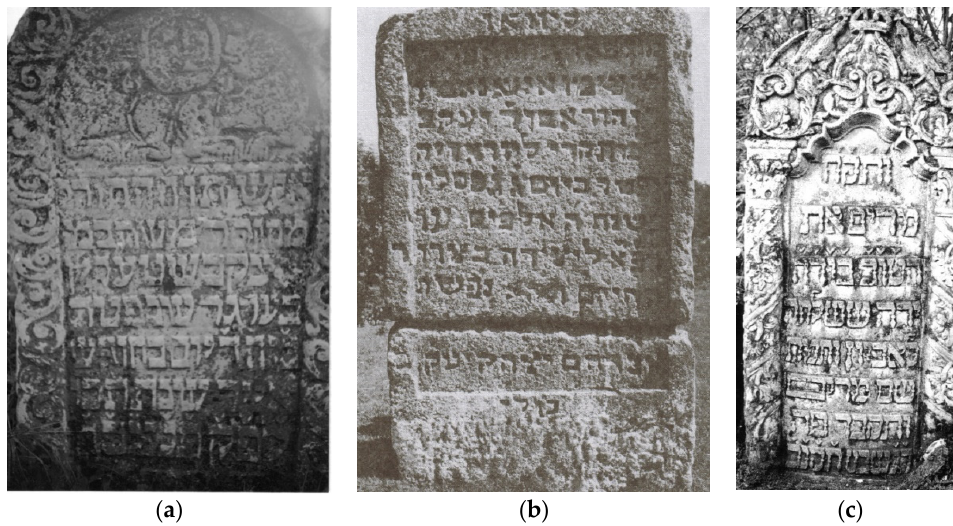
Figure 1. Jewish gravestones with Hebrew inscriptions from Ukraine. ( a ) Moses Shterkberger, 1666 CE, Trostyanec ( b ) Yehuda (Ide), 1520, Busk ( c ) Miriam, 1792, Buczacz (photo by M. Kheyfets). Three Biblical quotations are found in this epitaph: The choice between the Hebrew or Yiddish orthographies marks whether a particular word (and realities designated by the word) are found in the Hebrew sacred text or the word is only related to everyday mundane reality.